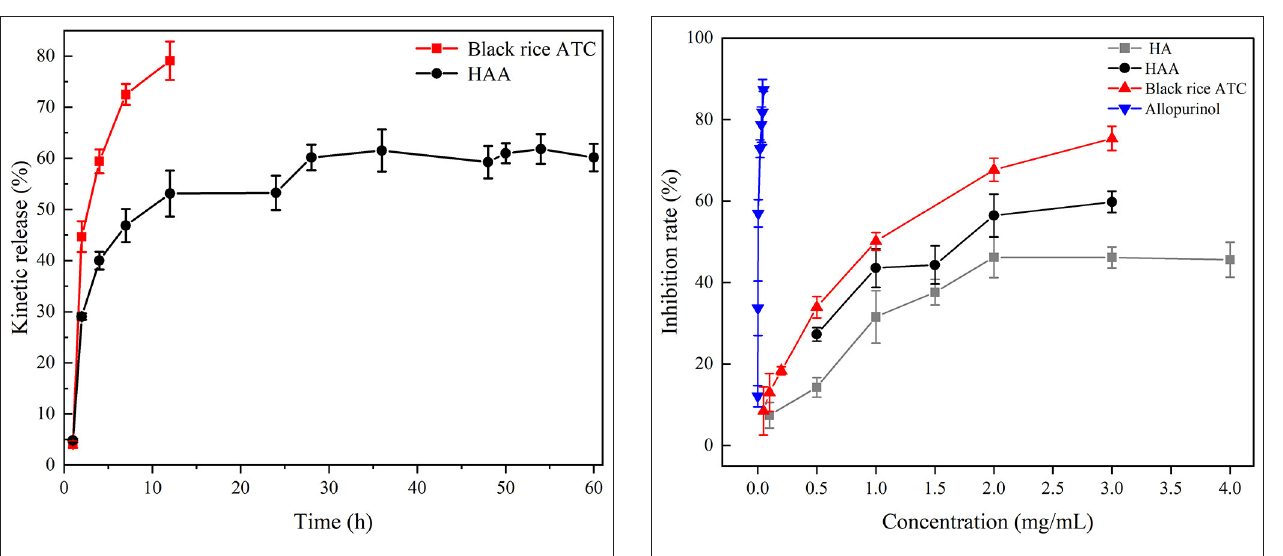
FIGURE 9 | The inhibitory effect of black rice ATC, HA, and HAA nanocomposite particles on